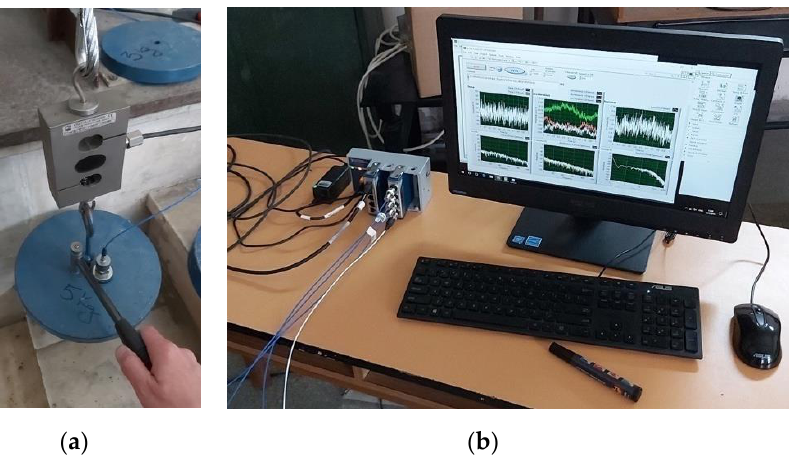
Figure 2. Details regarding testing procedure: ( a ) the scheme of initial impact pulse application using the impact hammer; and ( b ) ensemble view of digital acquisition system and computer with data management application.